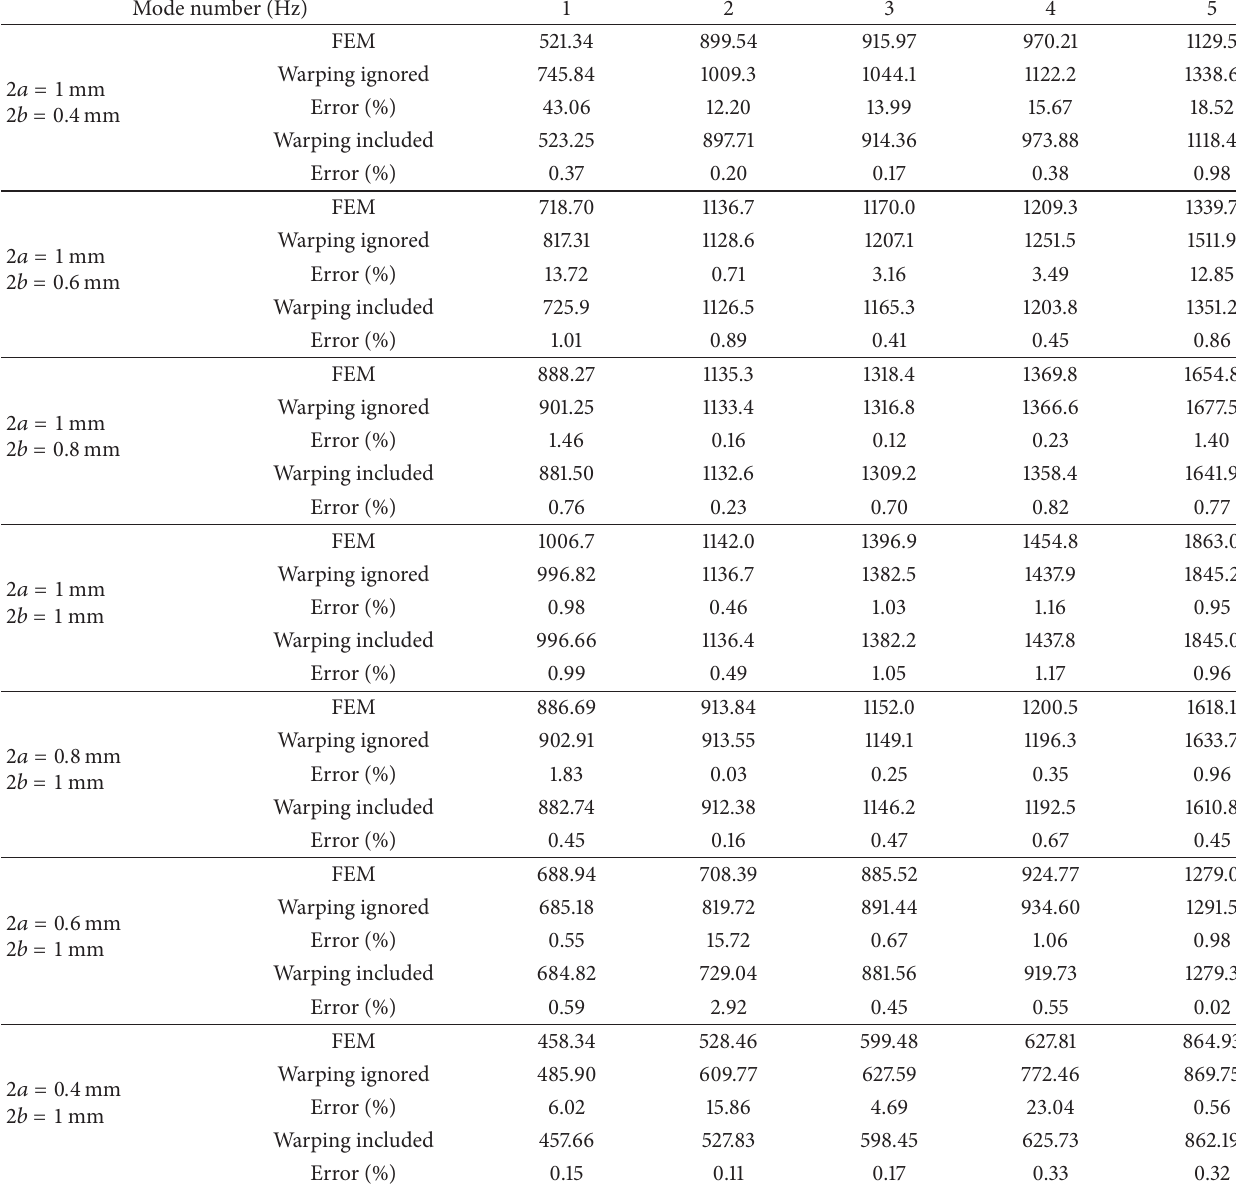
Table 3: Change law of the warping effect on natural frequencies with respect to the aspect ratio ( 𝑎/𝑏 ) of the rectangular cross